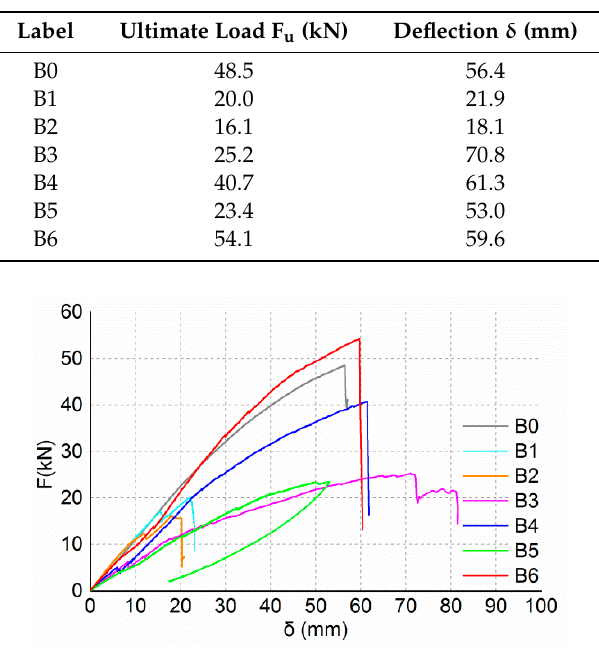
Table 7. The ultimate load values and the corresponding deflection of bending beams.